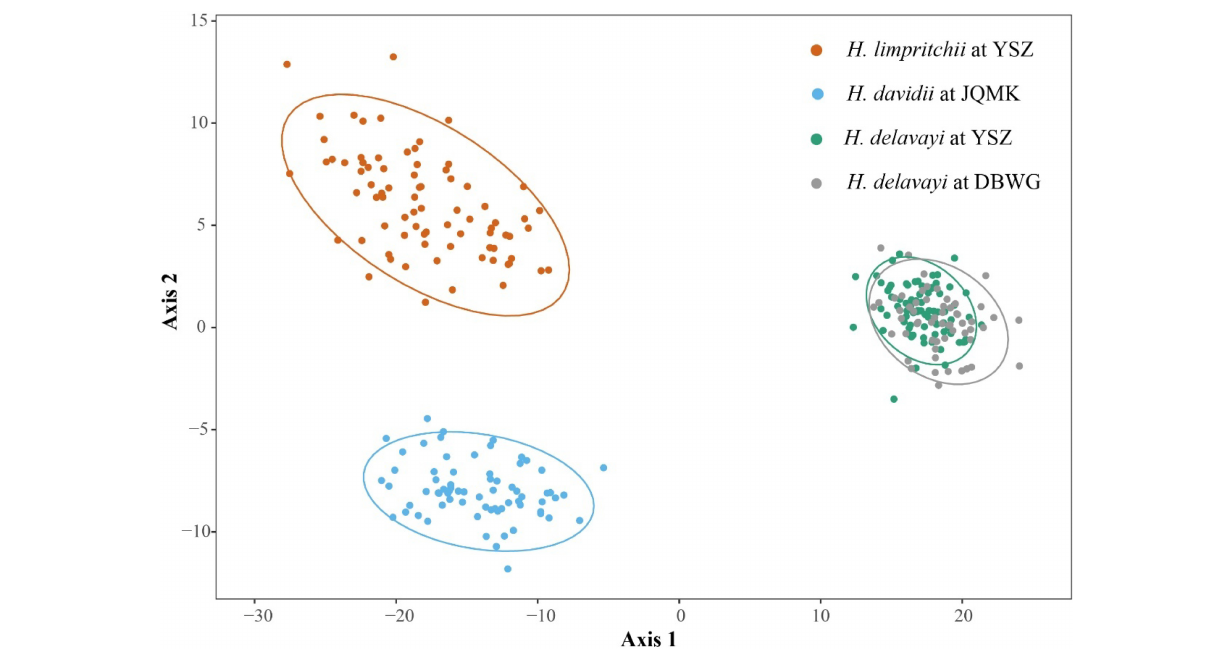
Frontiers in Plant Science |